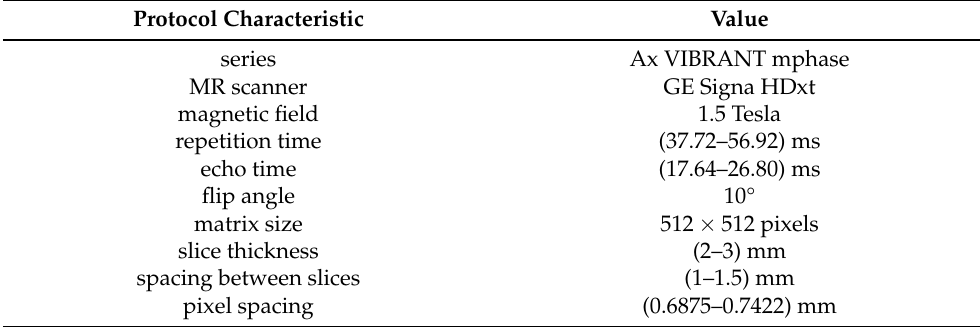
Table 1. Some relevant characteristics concerning the DCE-MRI imaging protocol. Protocol